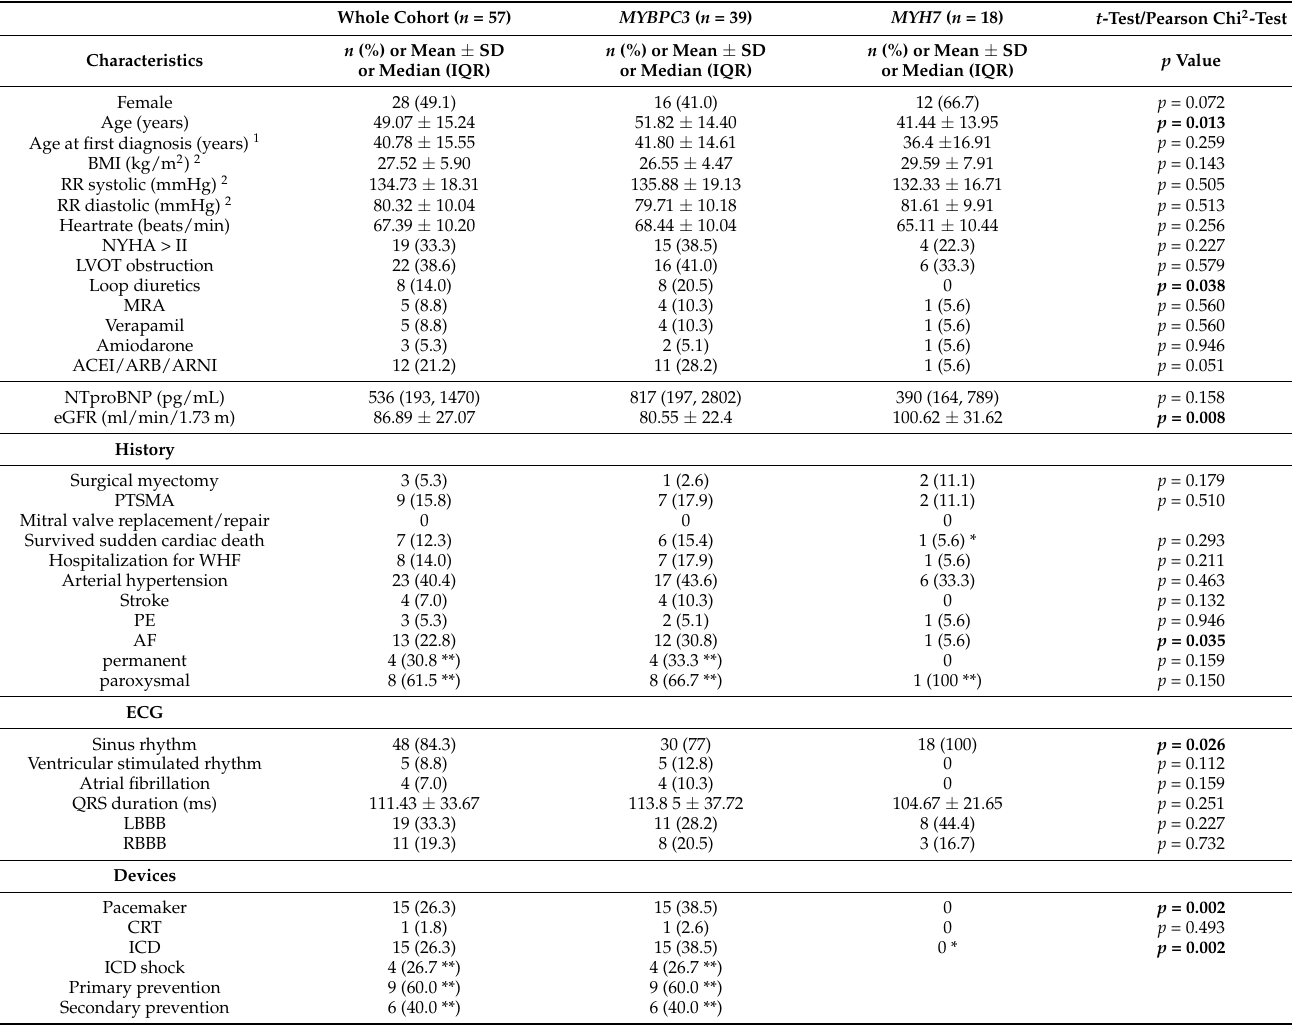
Table 2. Clinical characteristics and medical